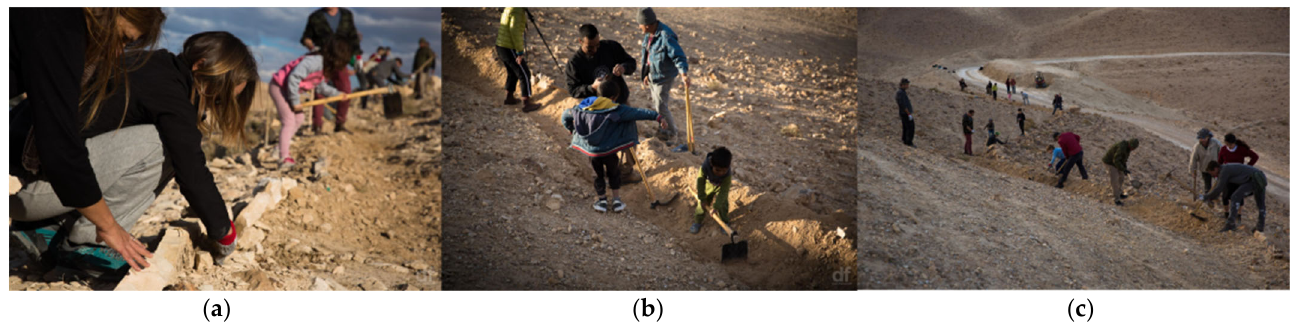
Figure 8. ( a – c ) Volunteers in the first socially engaged act at Bir Umm al Atin Cistern cleaning and excavating the channels for runoff water to accumulate in the cistern, December 2019. Photographed by Dan Farberoff. Images courtesy of the artist.